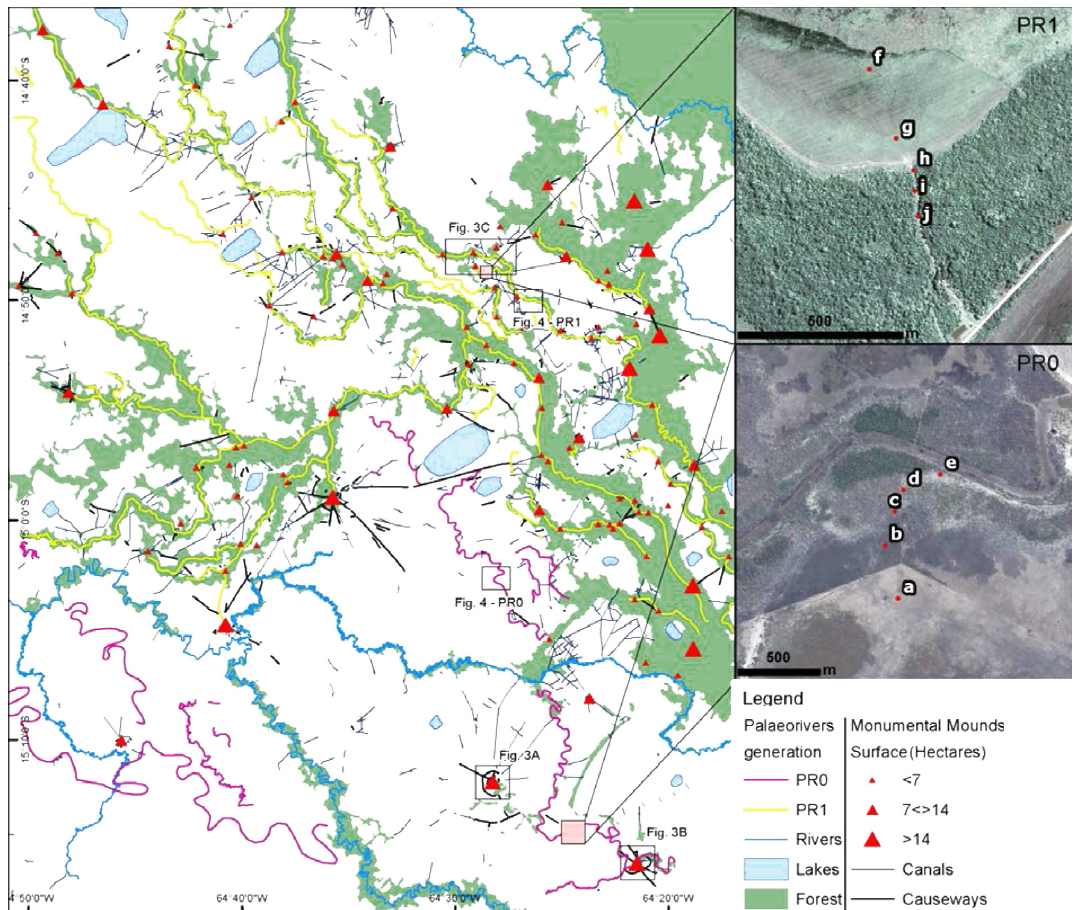
Figure 2. Map of rivers, palaeorivers and pre-Columbian earthworks in the MMR and location of the soil profiles along the two levee– backswamp catenas shown in Figs. 5 and